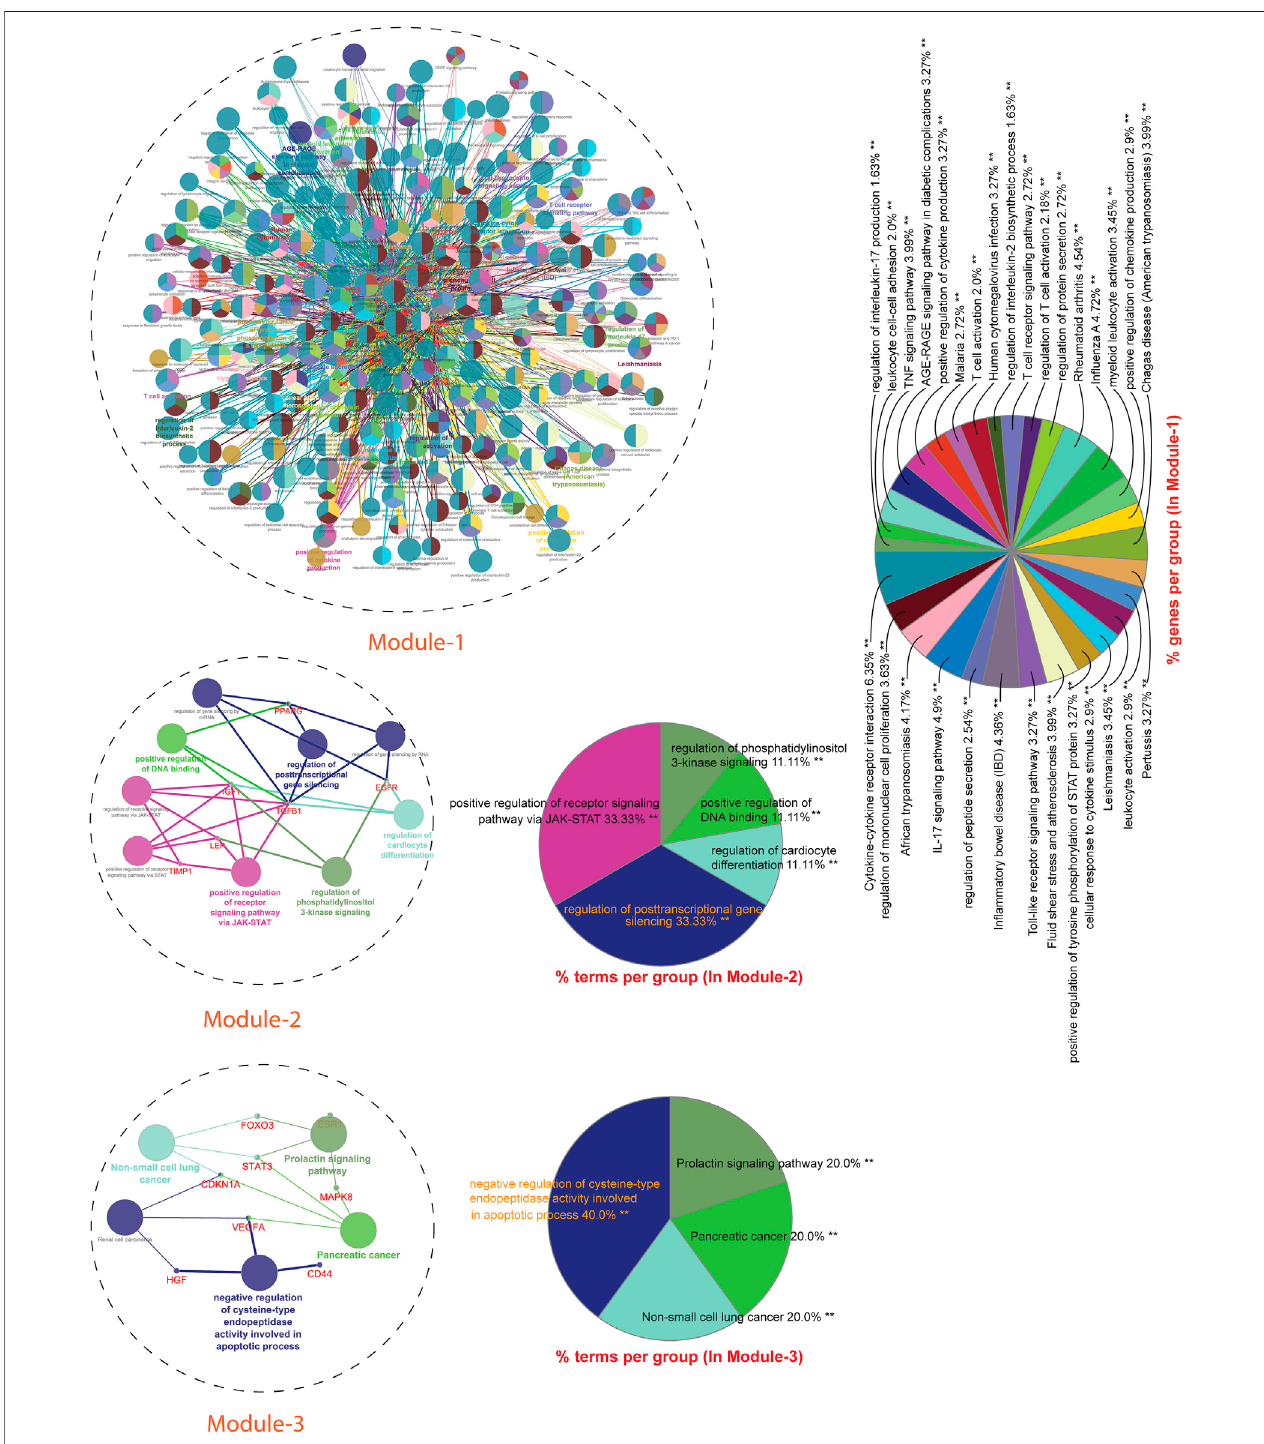
FIGURE 7 | GO enrichment Analysis: Network representation shows the various biological processes and pathways enriched by genes of module-1 to module-3. Each node representsapathway andbiologicalprocess. Thenode sizere fl ectstheenrichmentsigni fi cance ofpathway andbiologicalprocesses. Nodecolorshows the class that they belong to. Mixed coloring means that the particular node belongs to multiple classes.